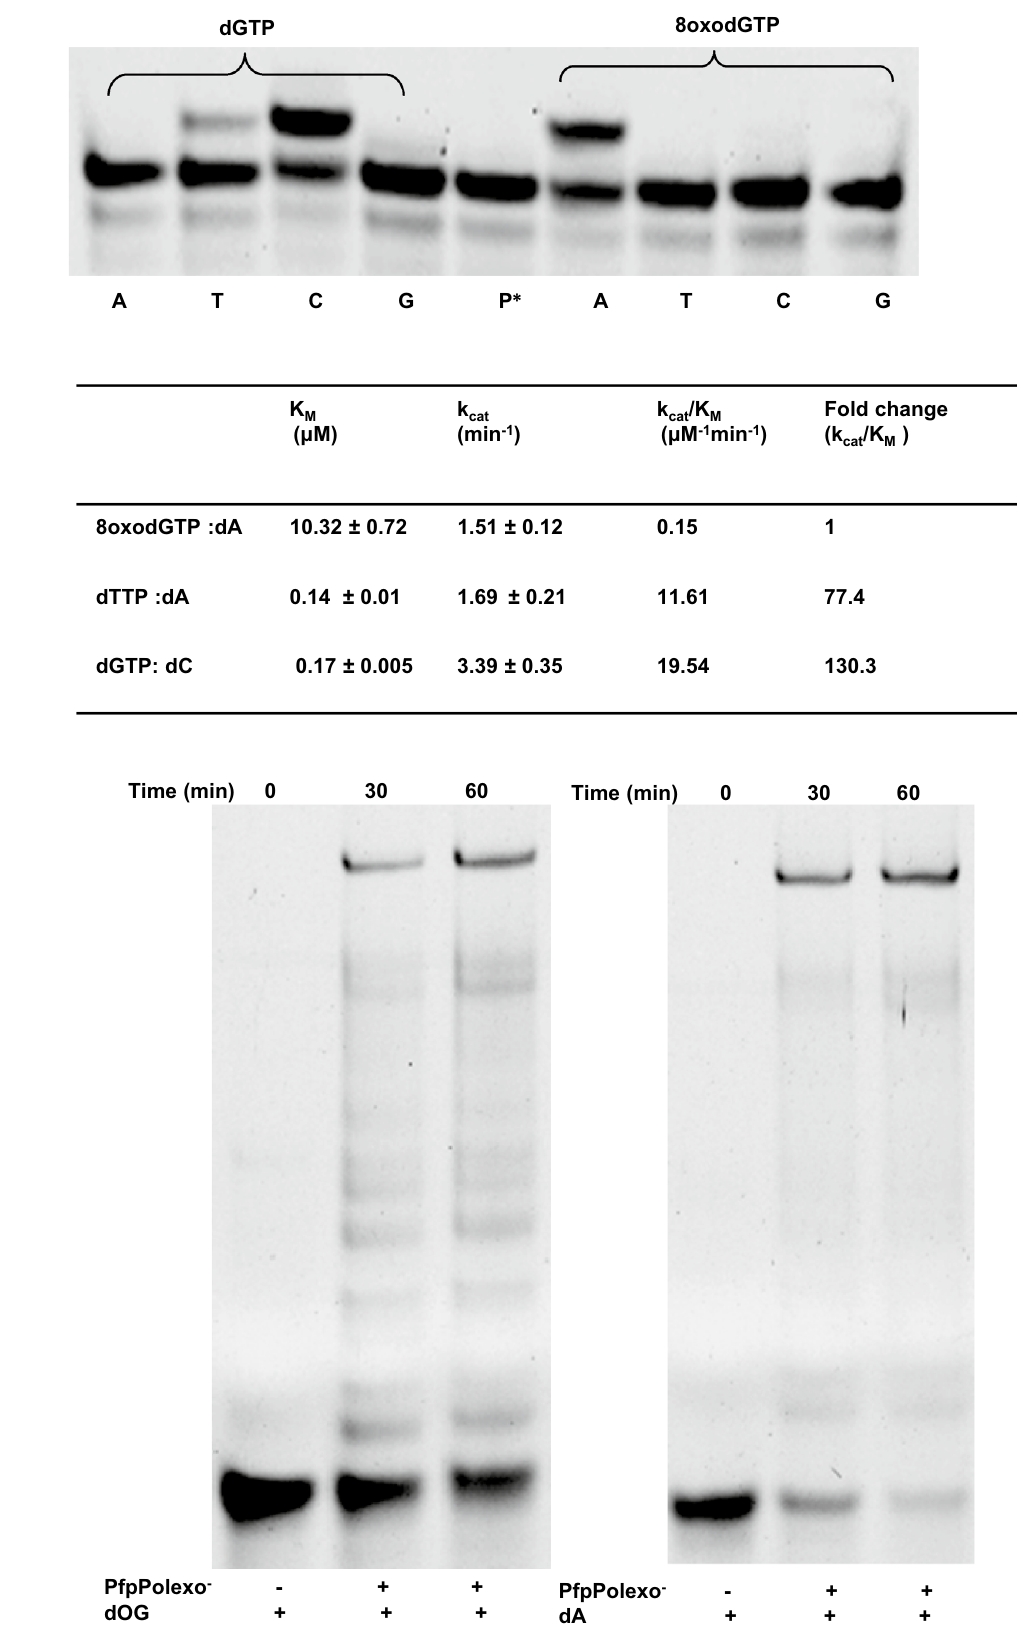
Figure 1. Activity of Pfprex vis-a-vis 8oxodGTP. ( A ) The ability of PfpPolexo − to incorporate dGTP and 8oxodGTP opposite all four template nucleotides was compared. 30 nM PfpPolexo − was incubated for 30